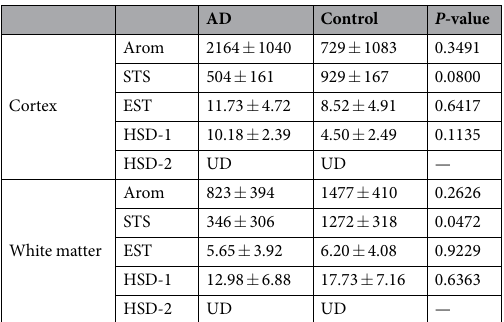
AD Control P -value